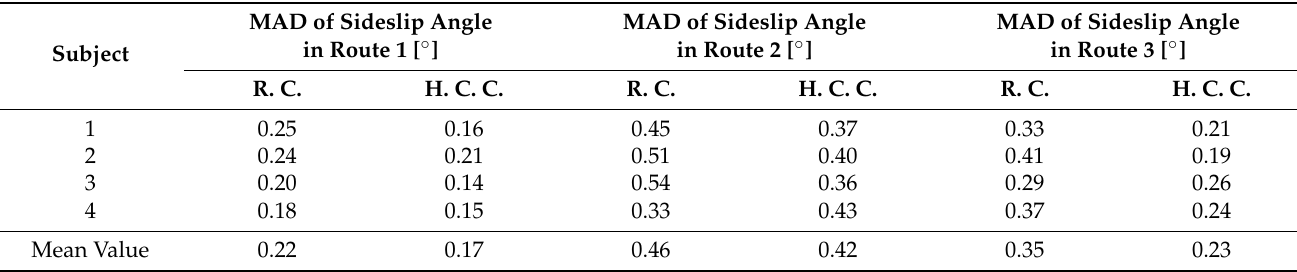
Table 3. MAD of sideslip angle of each subject in remote control and human-machine cooperative control mode in three